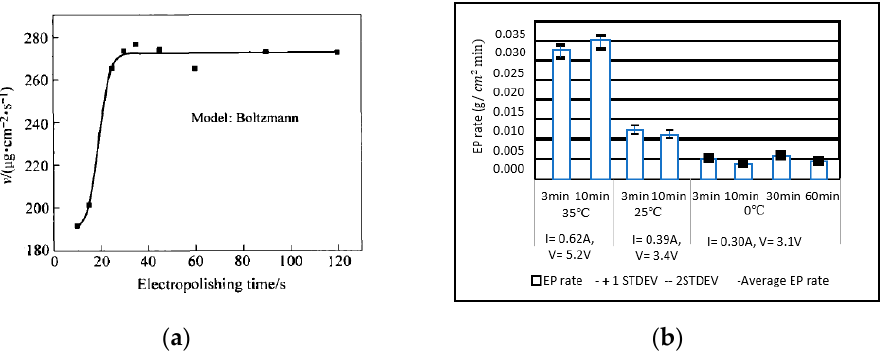
Figure 17. ( a ) The effect of electropolishing time obeys sigmoidal law [154], copyrights granted by Nonferrous Metals Society of China 2006, ( b ) EP rate of Co-Cr samples in phosphoric acid at tem- peratures of 35 °C, 25 °C, and 0 °C (after Aihara 2009) [140].